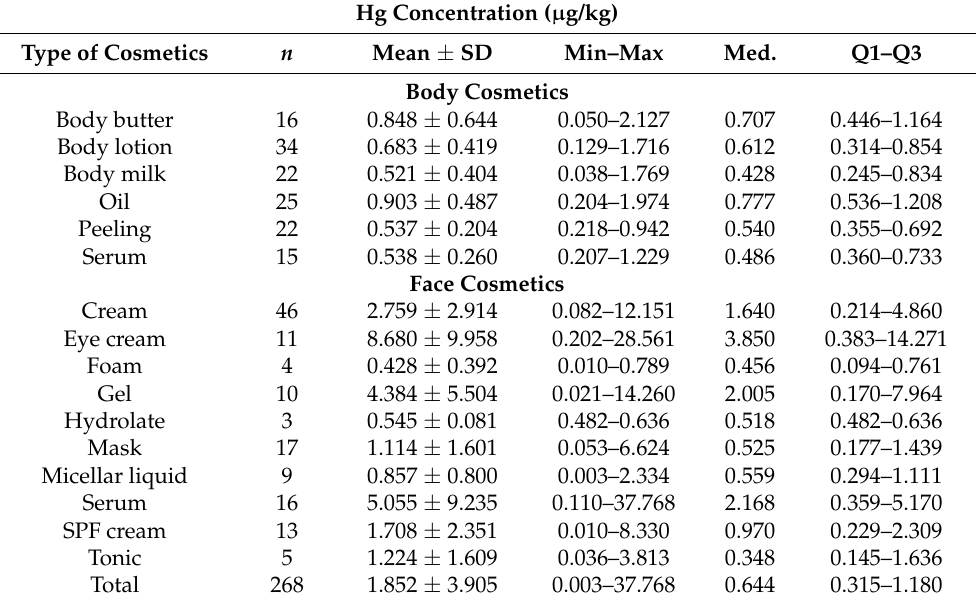
Table 1. Hg concentration in the tested